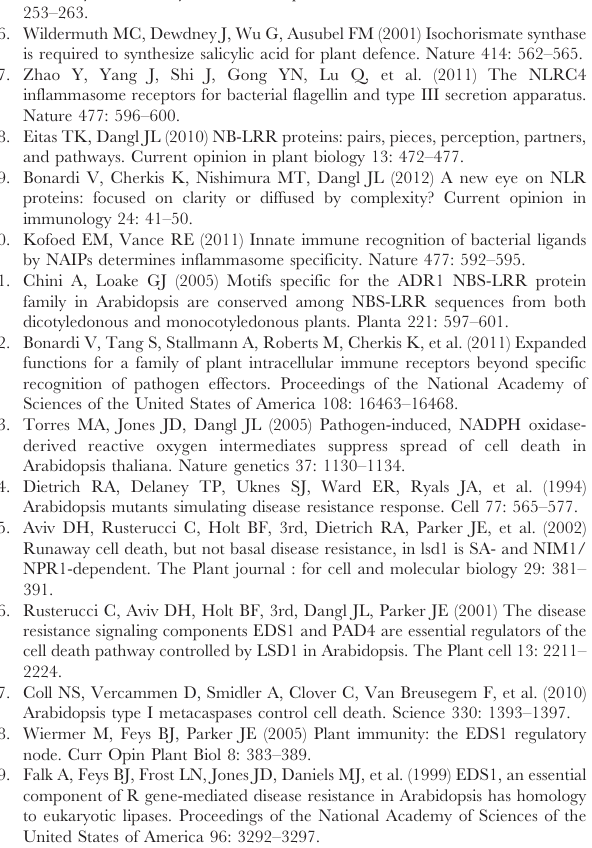
Table S1 ADR1-L2 D484V is lethal in an lsd1-2 background. Table of actual and expected genotypes of F3 progeny from a cross between lsd1-2 and ADR1-L2 D484V shows that no lsd1-2 homozy- gous plants were recovered from plants that were homozygous for ADR1-L2 D484V . ADR1-L2 D484V was also transformed into lsd1-2 , but no plants with a detectable amount of ADR1-L2 D484V protein were recovered. Table S2 Primer sequences used in this